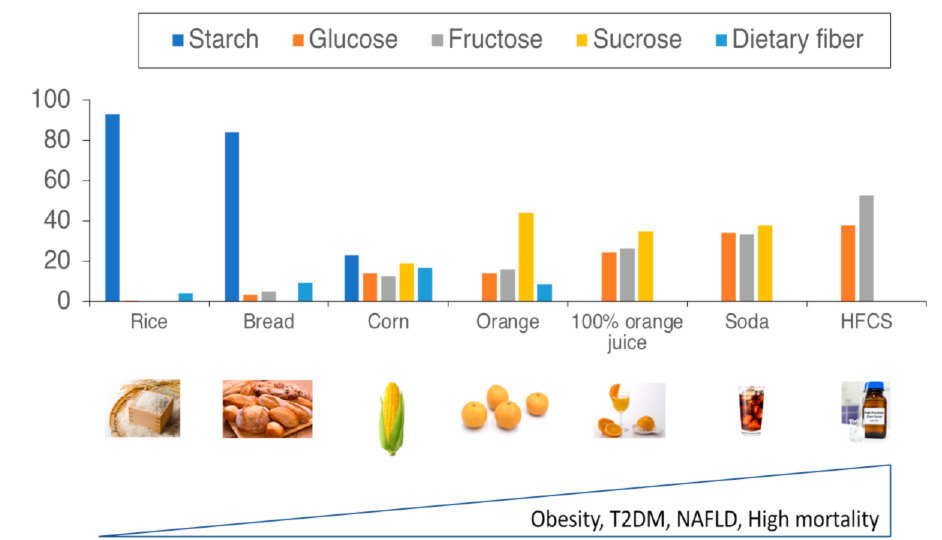
Figure 1. The association between carbohydrate type and